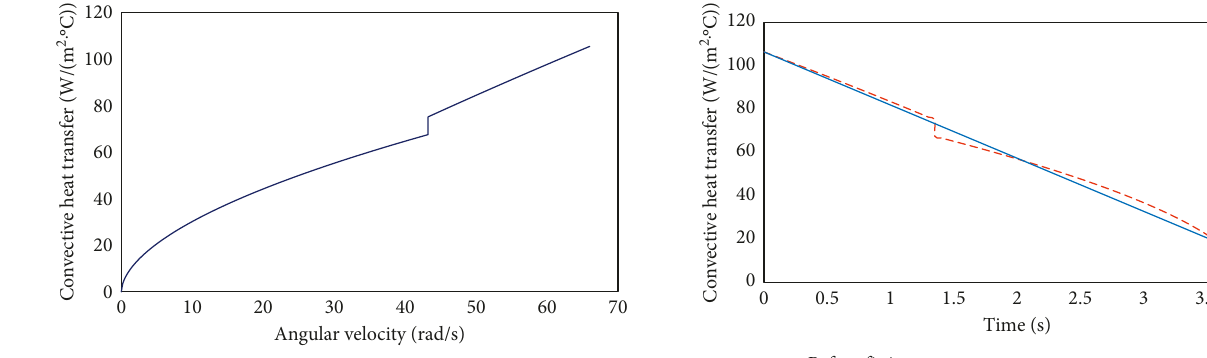
Figure 5: Change curve of the convective heat transfer coefficient with angular